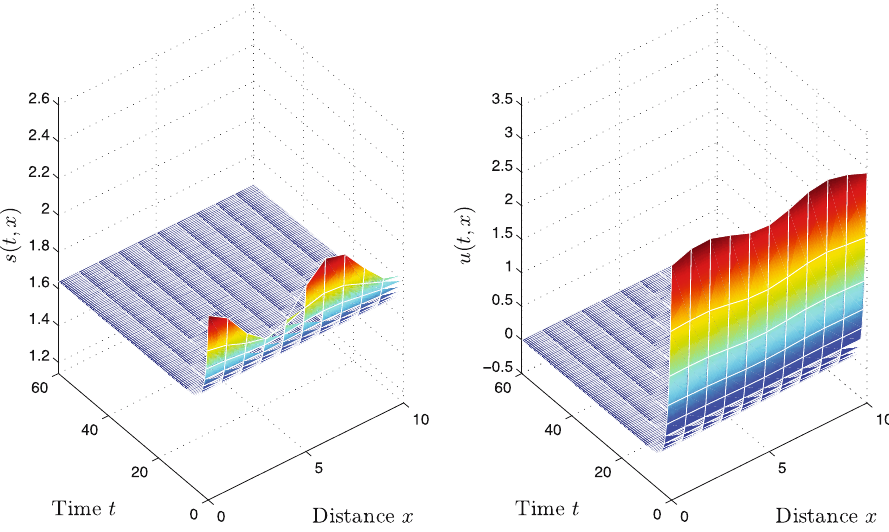
Figure 2: Numerical solutions of system ( 59 ) subject to the fi rst set of